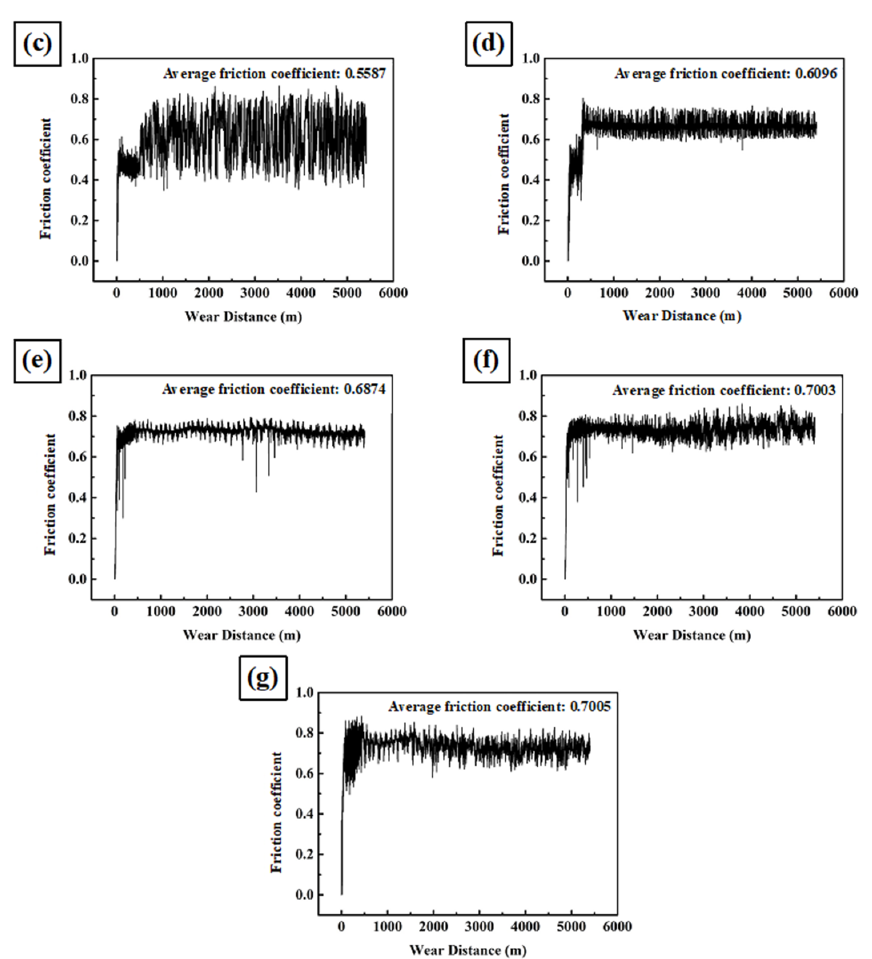
Figure 5. Friction coefficient as a function of wear distance of ( a ) SUS304, ( b ) A1, ( c ) A2, ( d ) A3, ( e ) A4, ( f ) A5, and ( g ) high-chromium cast iron.